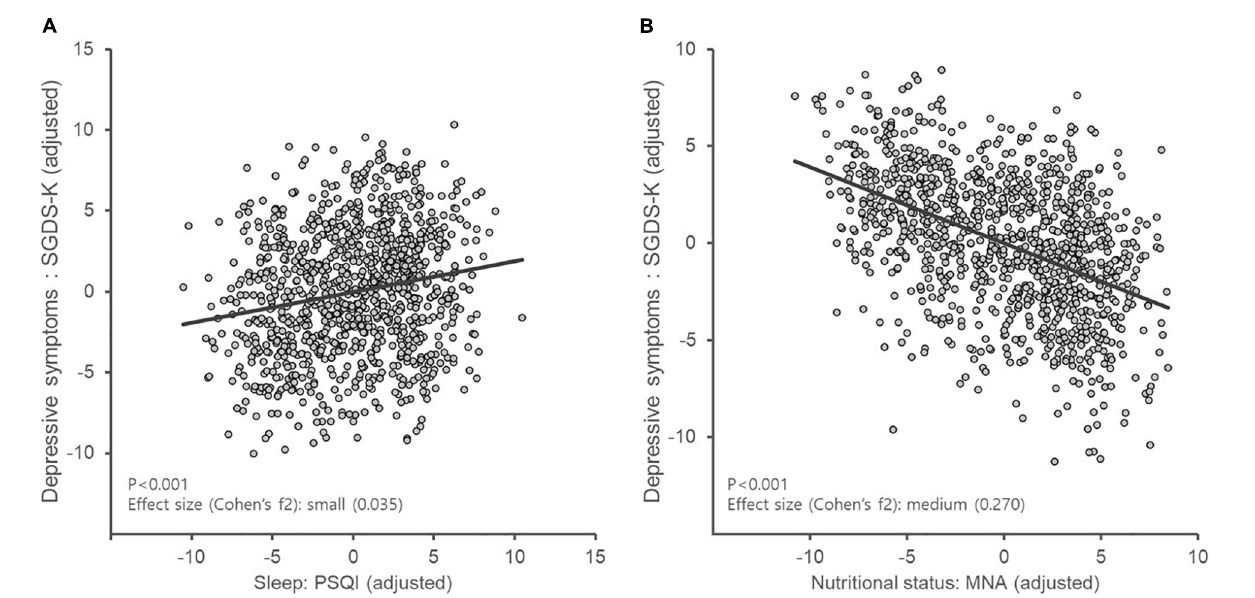
FIGURE 1 | Partial regression plot of depression considering sleep disturbance and nutritional status. MNA, Mini Nutritional Assessment; PSQI, Pittsburgh Sleep Quality Index; SGDS-K, Korean version of the Short Form of Geriatric Depression Scale. According to Cohen’s guidelines, the local effect size was small for PSQI (Cohen’s f2: 0.035) (A) and medium for MNA (Cohen’s f2: 0.270) (B)